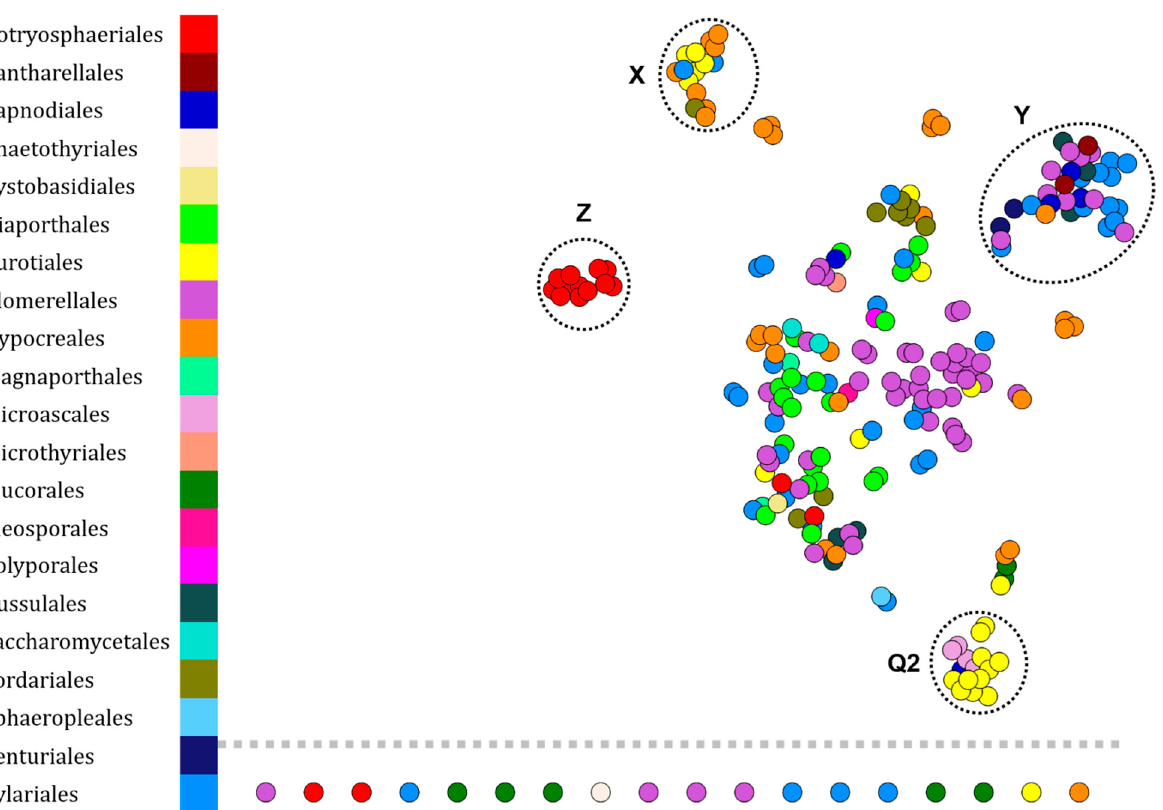
Figure 6. Visualization of 230 lipid fingerprints of environmental fungi (230 isolates—BNSB’s database) set by t-SNE. Each node represents the lipid fingerprint of an isolate and is colored according to the taxonomic order of the organism. Arrows indicate illogical attributions within clusters (annotated Q2, X, Y and Z).